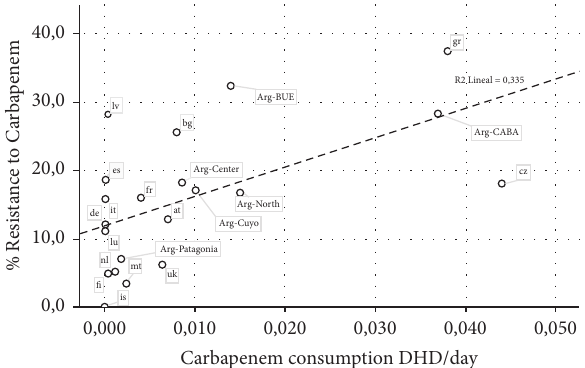
Figure 1: Carbapenem consumption and Pseudomonas aeruginosa resistance data (according to Argentinian region compared with European countries). Countries are named with their official country codes [23].